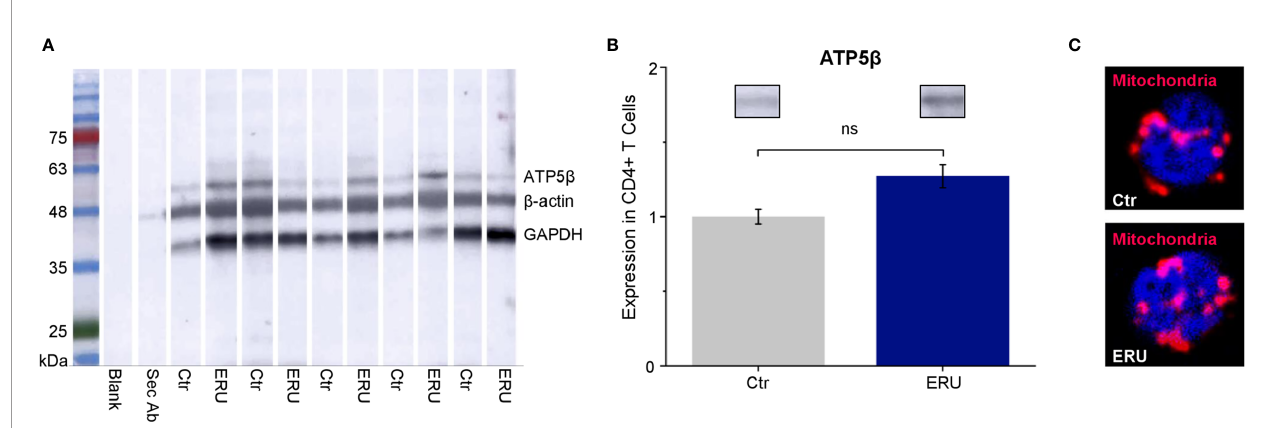
FIGURE 4 | ATP5 b in CD4 + T cells of healthy and ERU cases. (A) Western blot with CD4 + T cells of control and ERU horses (n=5 each) stained with anti ATP5 b antibody, anti GAPDH antibody and anti b -actin antibody for normalization. A molecular weight marker is shown on the left, followed by a blank lane and a lane only incubated with the secondary antibody. (B) Statistical analysis of the volume of ATP5 b lanes of control and ERU cases after normalization to the respective b -actin lane showed no signi fi cant difference (ns p > 0.05). Data are represented as mean ± SEM. The ERU bar (blue) was set accordingly to the control bar (grey), which was set as 1. (C) Representative immunocytochemically stained CD4 + T cell of a control (upper picture) and an ERU case (lower picture). Mitochondria were stained with MitoTracker Deep Red (red). Cell nuclei were counterstained with DAPI (blue). x1000 magni fi